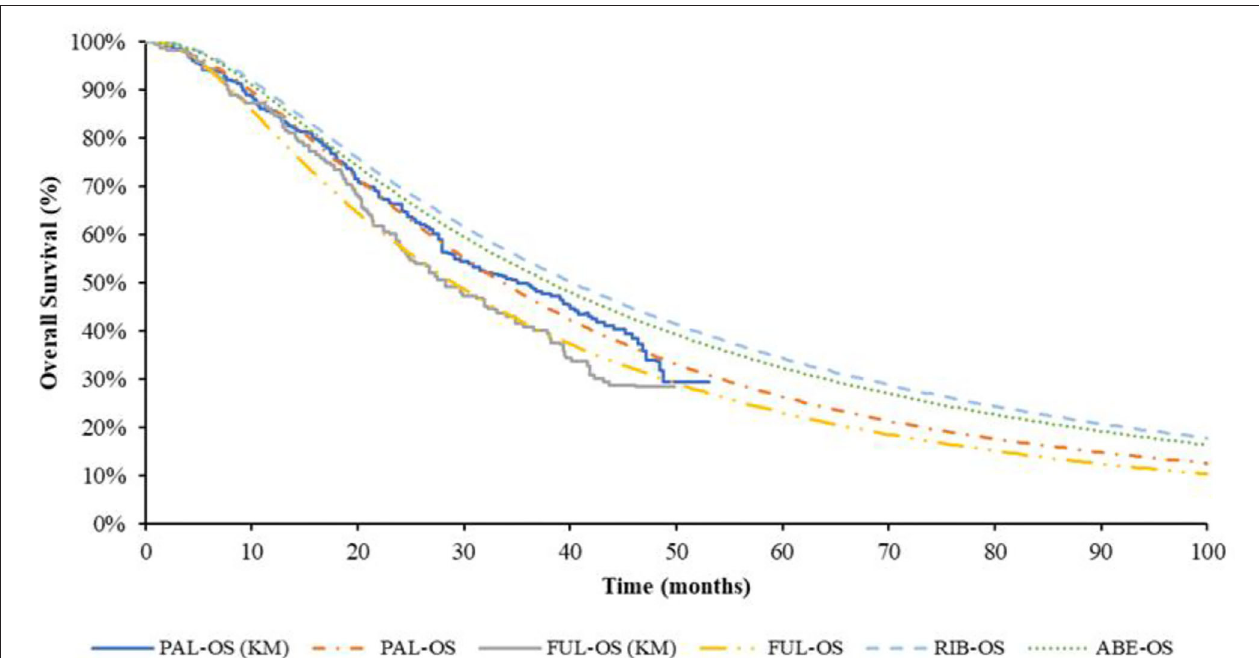
FIGURE 3 | K-M curve and parametric survival distributions for OS. OS, overall survival; ABE, abemaciclib; RIB, ribociclib; PAL, palbociclib; FUL, fulvestrant.